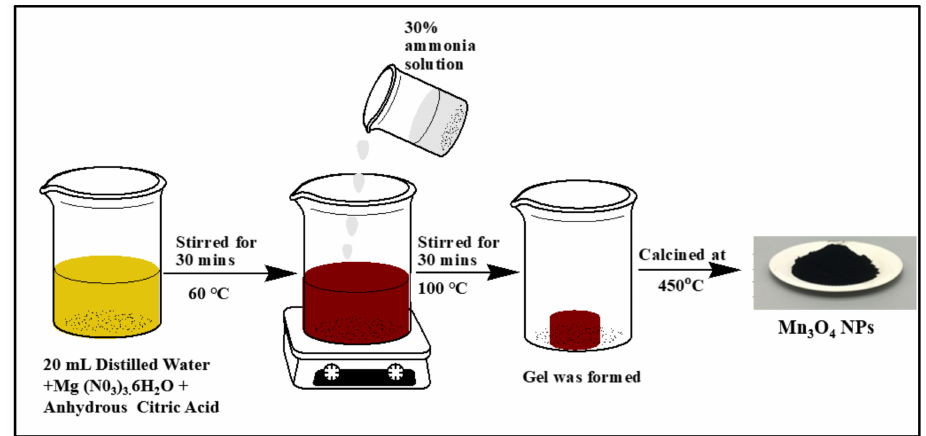
Scheme 2. Synthesis of manganese oxide nanoparticles using sol-gel